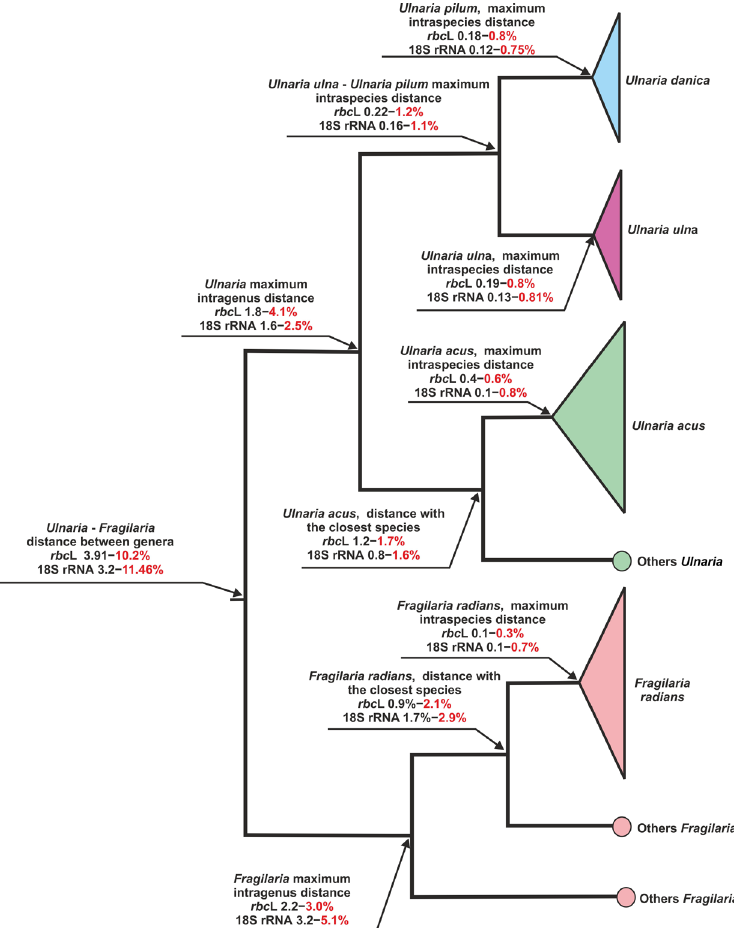
Figure 3. A general phylogenetic scheme of closely related relationships based on the results of reconstructions based on rbc L and 18S rRNA markers of the diatom species isolated in the work. The reconstruction nodes show 95% confidence intervals of genetic distances (BEAST analysis for rbc L, ultrafast bootstrap analysis in IQ-TREE for 18S rRNA).